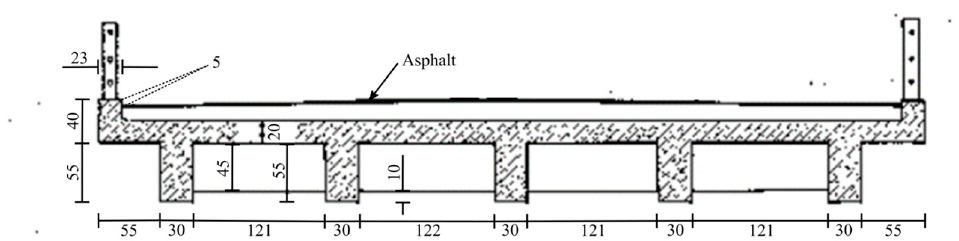
Figure 4. Section view drawing and reinforcement location and type (all measurements in cm). The bridge was constructed as an in situ cast concrete bridge and consisted of one transverse beam and five longitudinal beams that were cast together with the bridge deck plate. The web height of the centrally placed transverse beam was 45 cm, whereas the five longitudinal beams had a height of 55 cm with a horizontal and vertical edge chamfer distance at the ends of approximately 80 cm and 15 cm, respectively. The centrally placed transverse beam height of 45 cm thus leaves 10 cm distance to the bottom face of the longitudinal